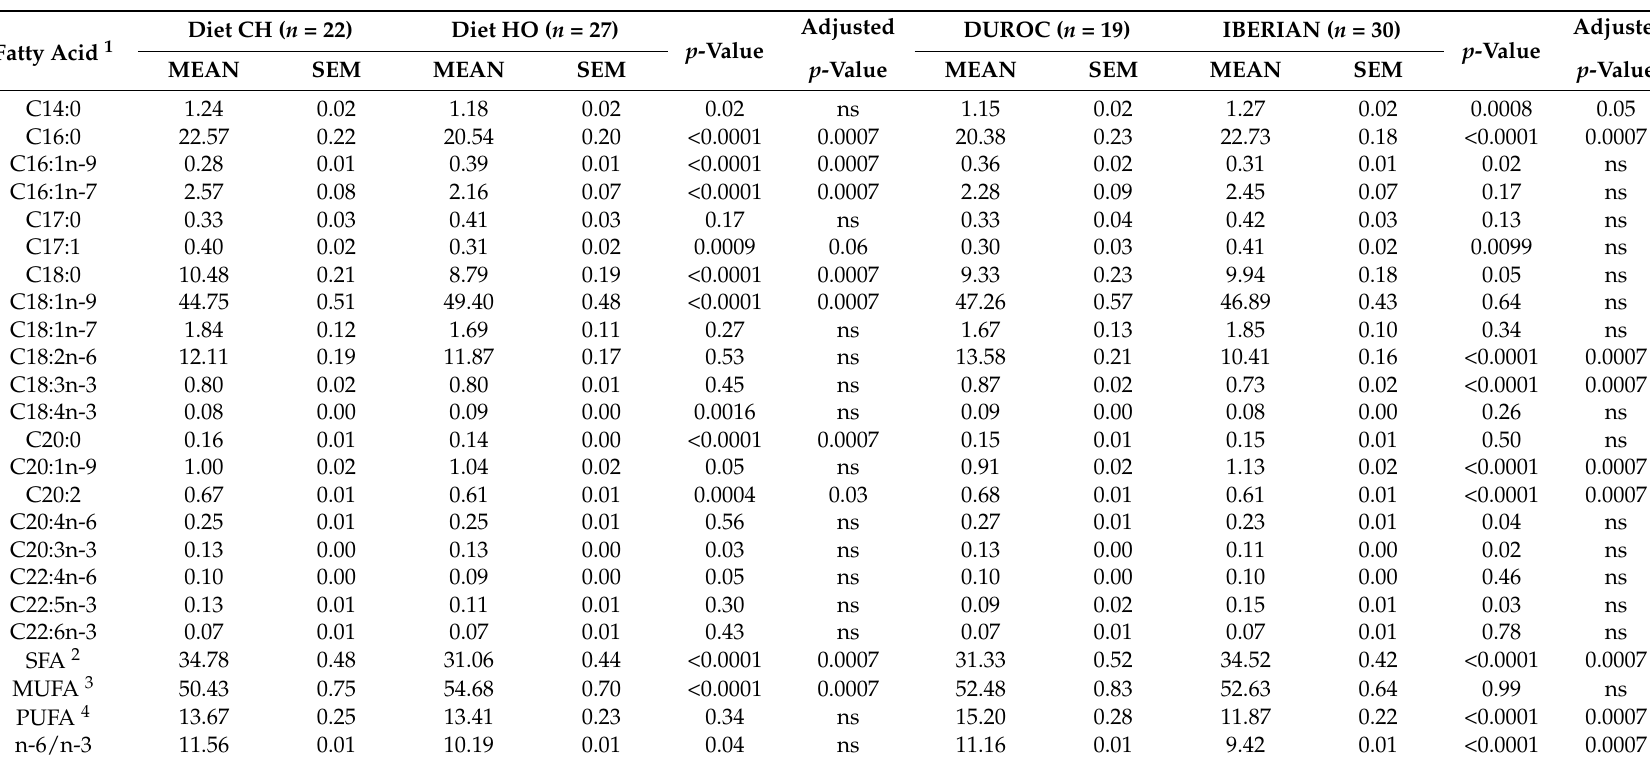
Table 2. Least-squares means and standard errors (SEM) of fatty acid percentages in subcutaneous ham fat (inner layer) from Iberian and Duroc pigs fed with a diet enriched with high-oleic sunflower oil (HO) or a standard diet with carbohydrates as energy source